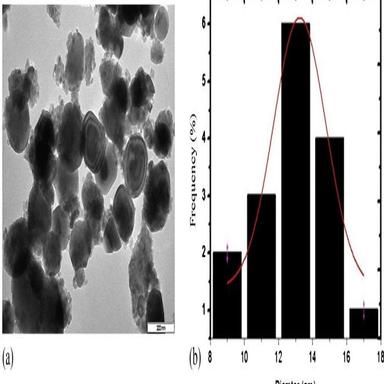
TEM images: (A) Images of TiO2-EB after ball-milling for 200 min; (B) Normal distribution of TiO2-EB particle size.